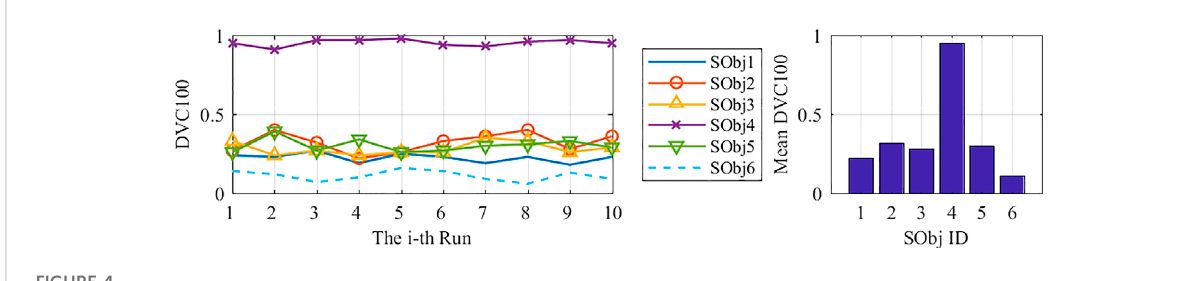
FIGURE 4 SDD results in case 3 using the fi rst fi ve modes.